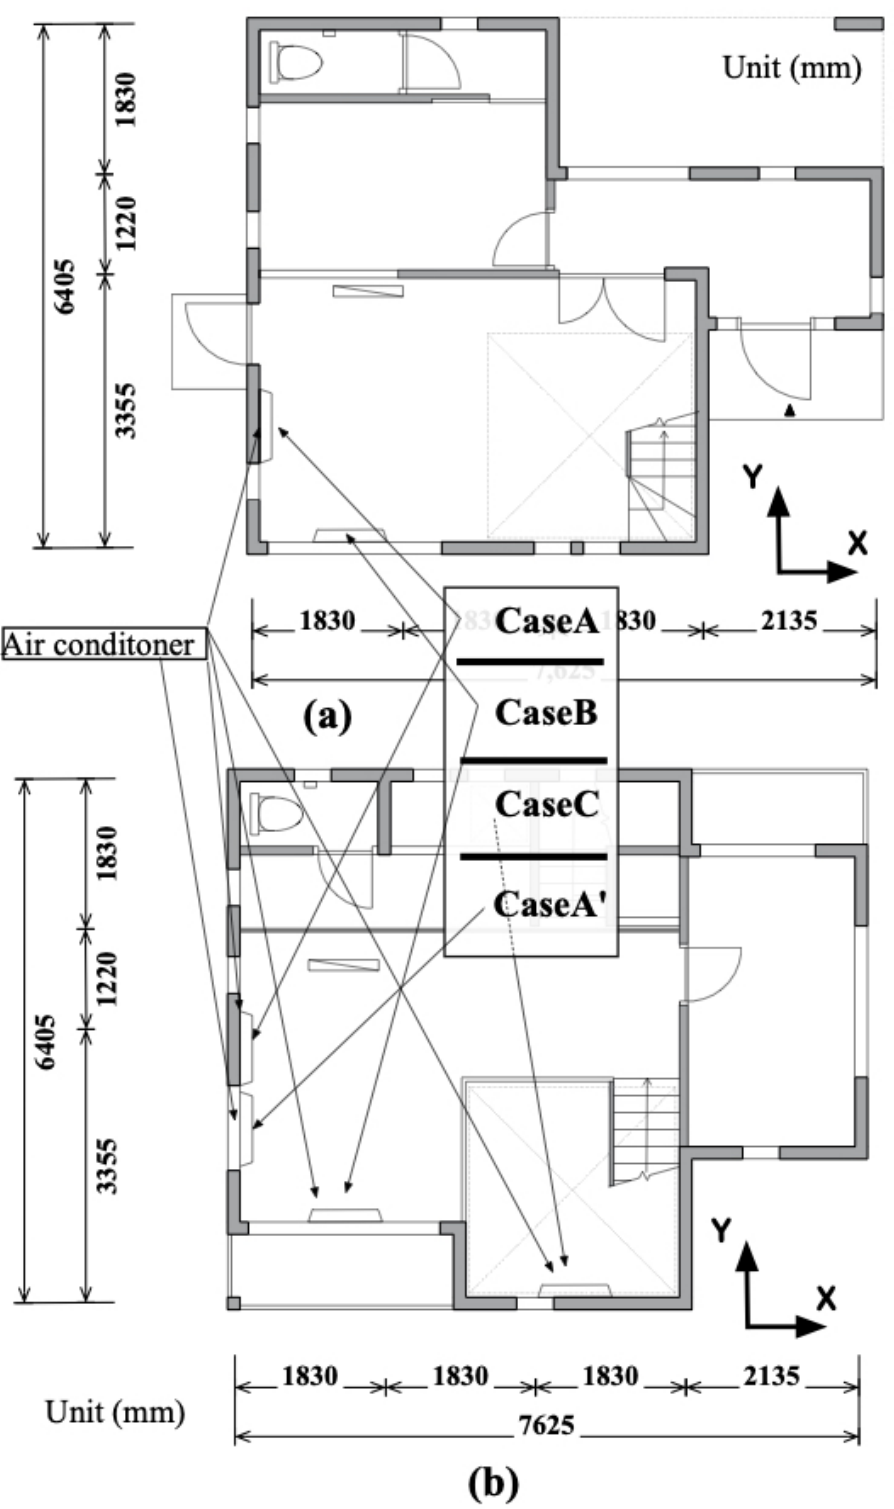
Figure 8. Air conditioner placement in Cases A, B, C, and A ′ ( a , b ). Shading indicates the air condi- tioner used in each case.